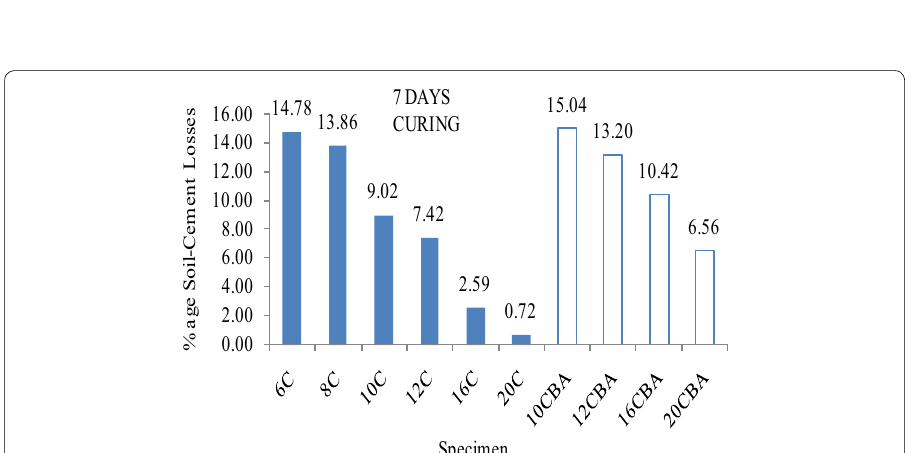
Fig. 9 Soil-cement losses for different specimens which completed 12